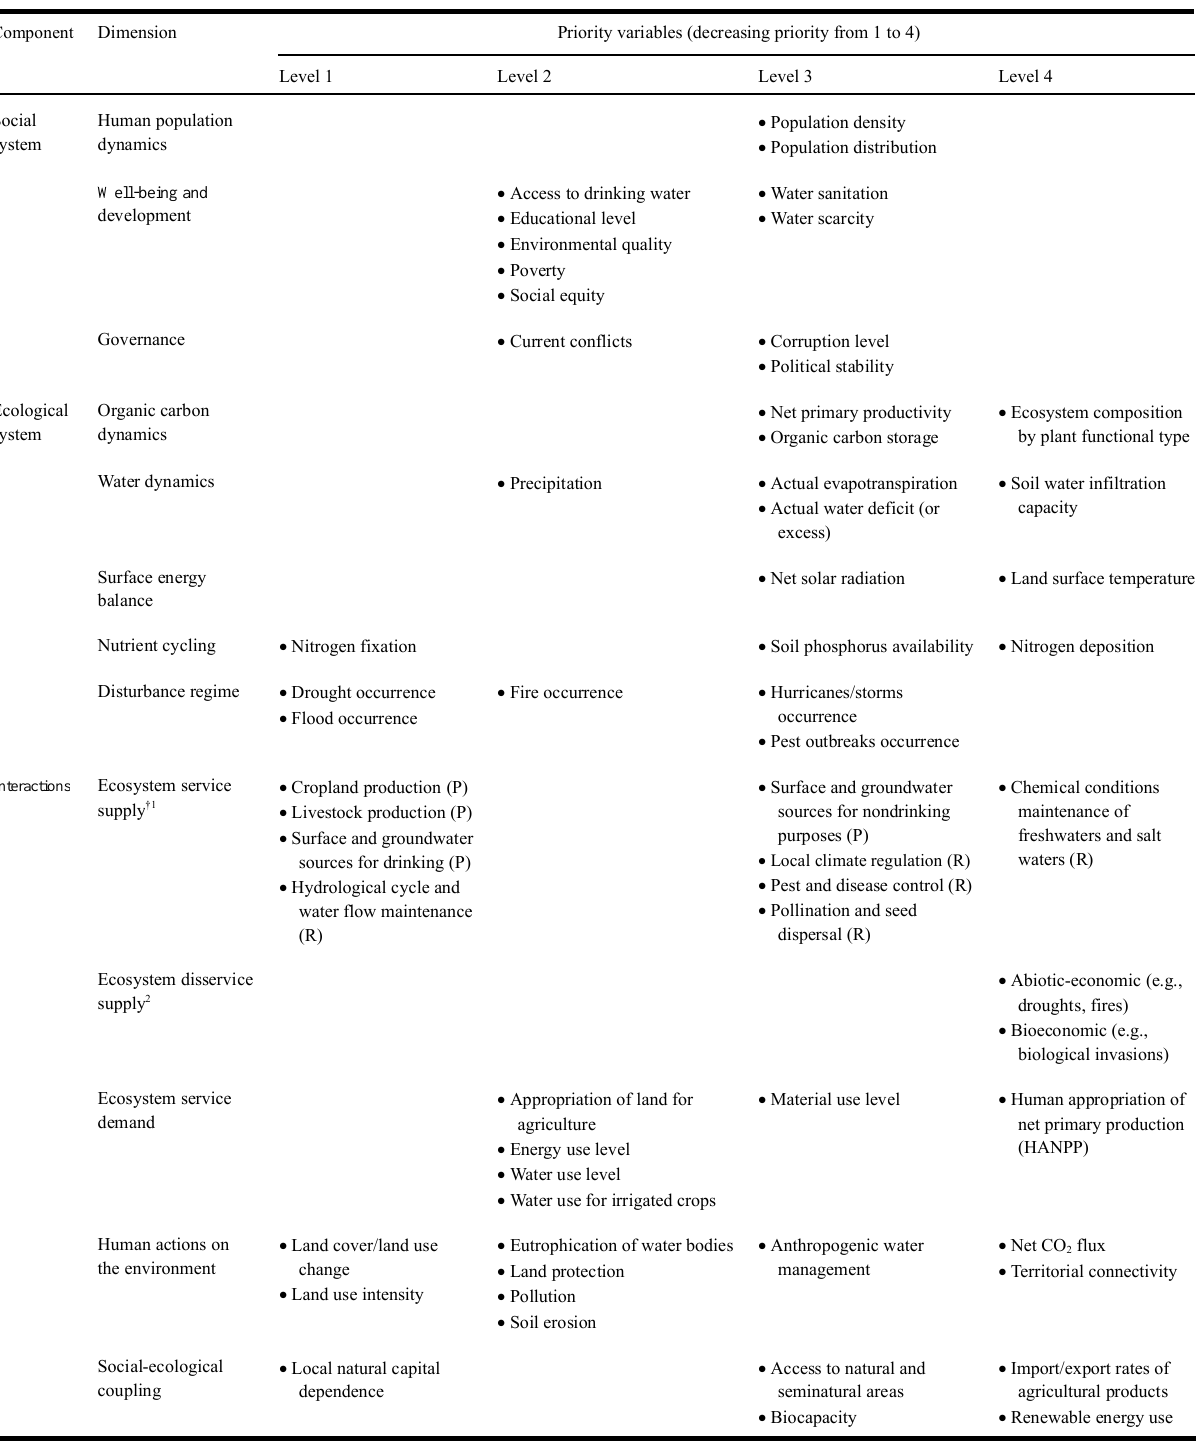
Table 1. List of prioritized variables for characterizing and monitoring social-ecological systems (SESs). The list is structured into 13 dimensions across the three components of a SES (see Fig. 2). Priority level 1 includes variables with relevance and consensus above the 90th percentile; level 2 includes variables with both values between the 75th and 90th percentile; level 3 contains those variables whose relevance was above the 75th percentile and consensus between the 50th and 75th percentiles and vice versa; and finally, level 4 includes those variables with relevance and consensus between the 50th and 75th percentiles. An extended version of this table including the nonpriority variable category, as well as examples and explanations for the variables, is available in Table A5.2, Appendix 5. Component